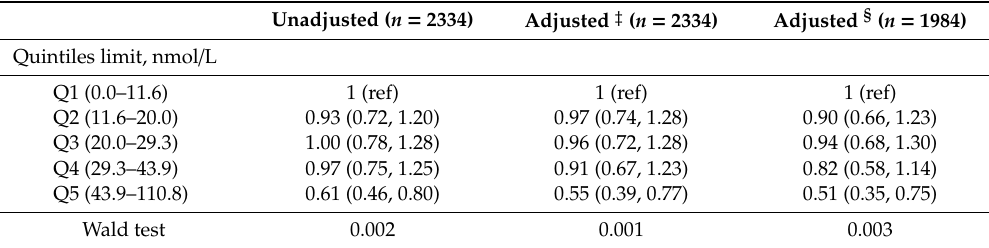
Table 2. Unadjusted and adjusted hazard ratio † (95% CI) of asthma among Danish children age 3–9 years, according to quintiles of neonatal 25(OH)D 3